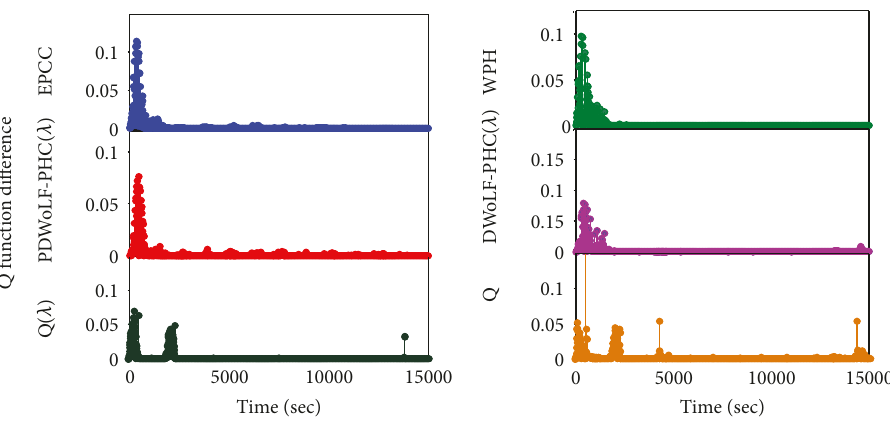
Figure 8: The convergence of di ff erent methods obtained during the